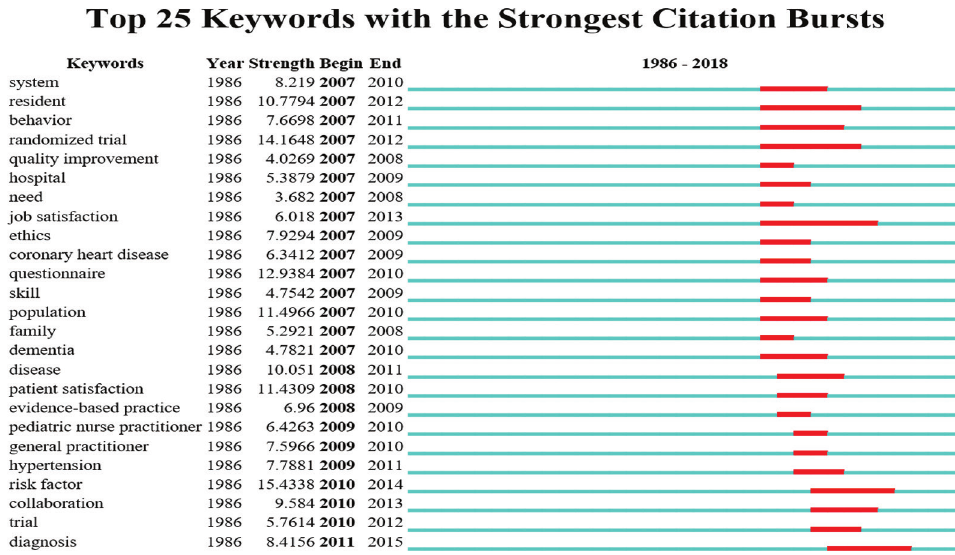
Table 8. The top 10 keywords according to the occurring